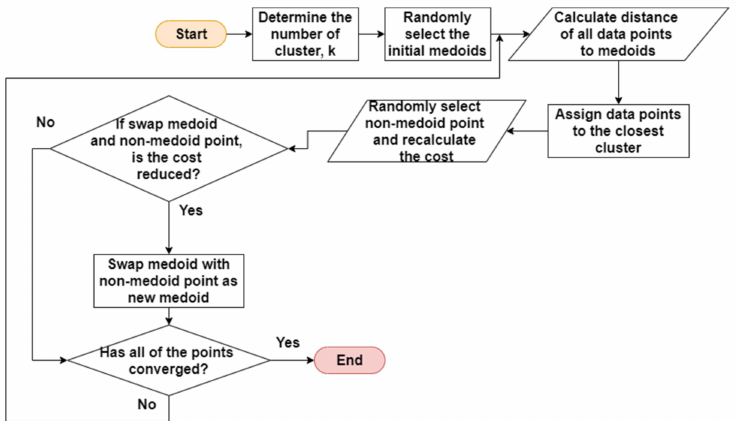
Figure 3. Basic steps of k-medoids clustering.